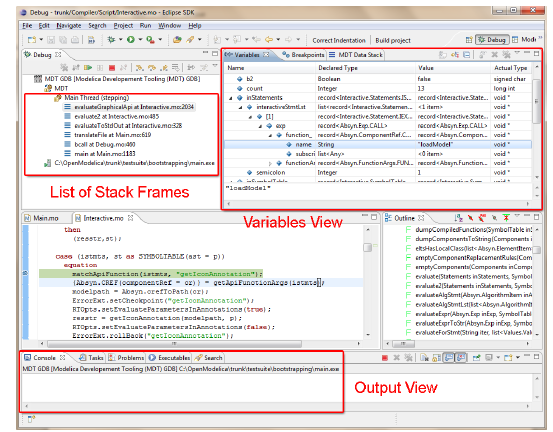
Figure 3: The debug view of the new efficient